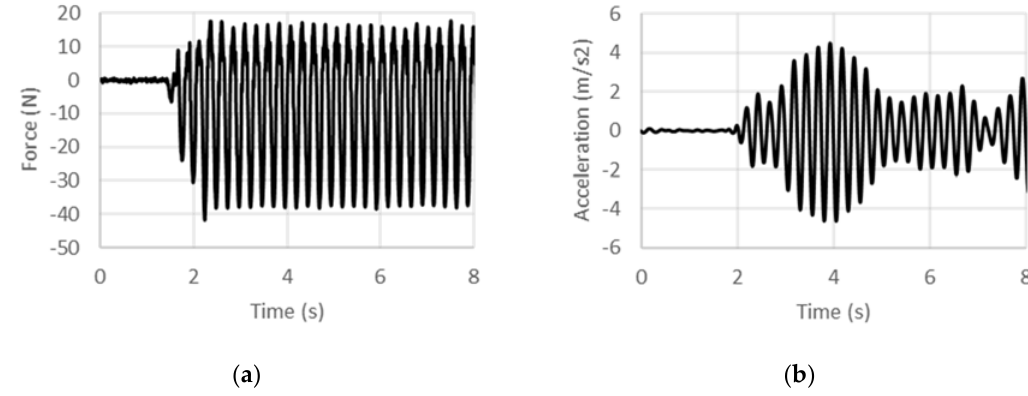
Figure 14. Experimental ( a ) force and ( b ) acceleration histories at 4 Hz under acceleration control.